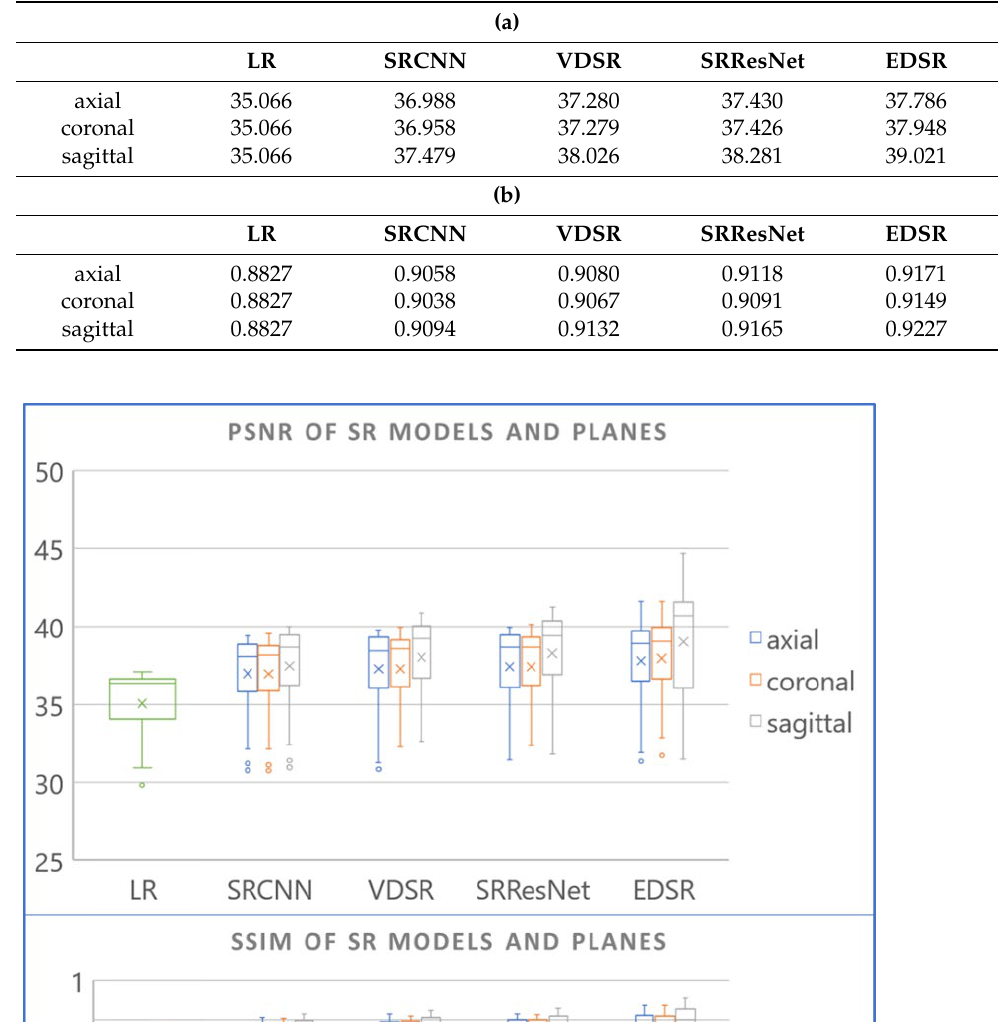
Table 5. Mean image quality metrics of different SR images compared to the ground-truth HR images. Although LR is not an SR model, we duplicated the LR results in all three planes. ( a ) Mean PSNR of different SR models applied to the three planes. ( b ) Mean SSIM of different SR models applied to the three planes.